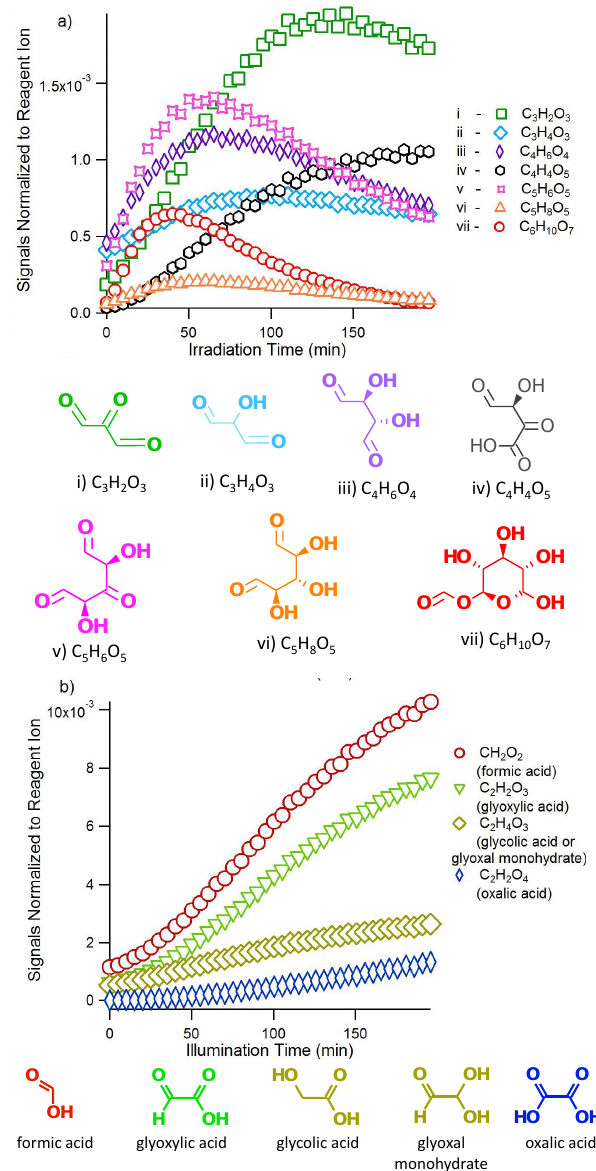
Figure 5. Evolution of bond-scission products measured by the I ( H 2 O ) − n reagent ion. Selected major products with three to six carbons are shown in (a) , with their proposed structures. The pro- posed reaction mechanisms leading to their formation are attached in Supplement Fig. S1. Formation of small organic acids with one or two carbons are shown in (b) . All the signals have been normalized against the reagent ion (I ( H 2 O ) − ) at m/z